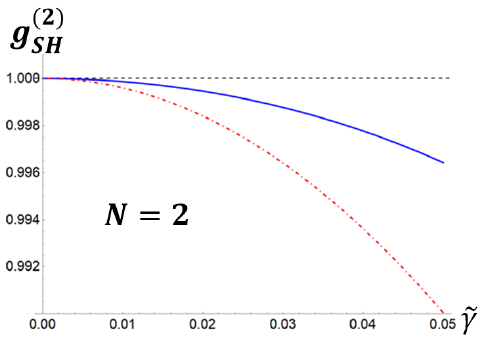
Figure 2. Coherent input state. Solid blue line: SH autocorrelation function, from Equation (46). Dashed line: SH autocorrelation function in the absence of annihilation processes and